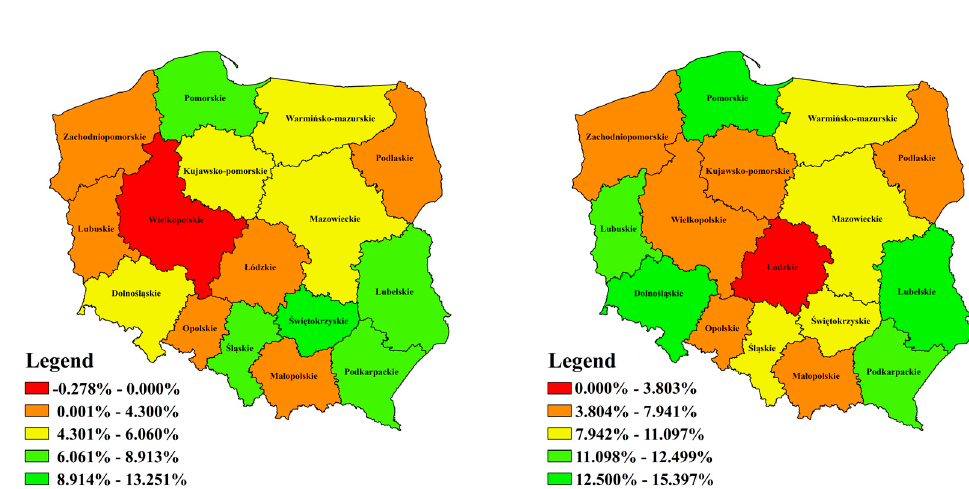
Figure 2. The dynamics of 2013–2021 change in value of medical services paid per